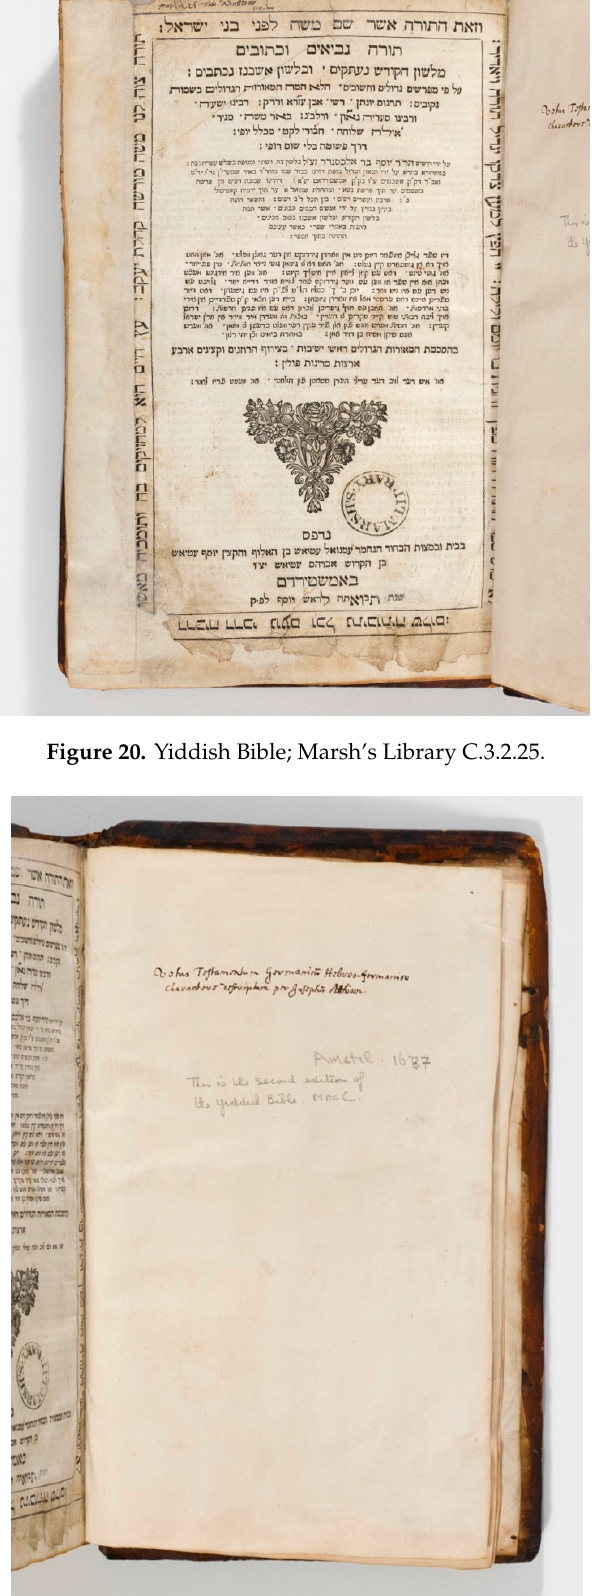
Figure 21. Inscription on Yiddish Bible; Marsh’s Library C.3.2.25.